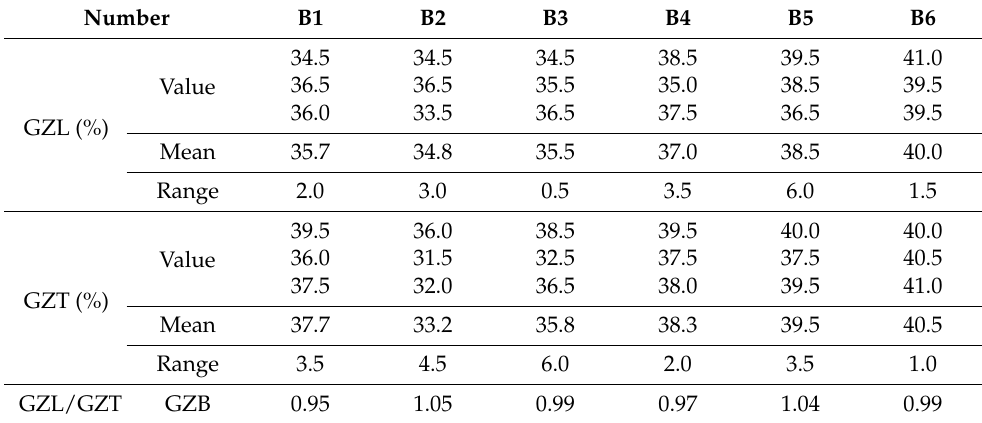
Table 6. The measured value of gloss for Group B.